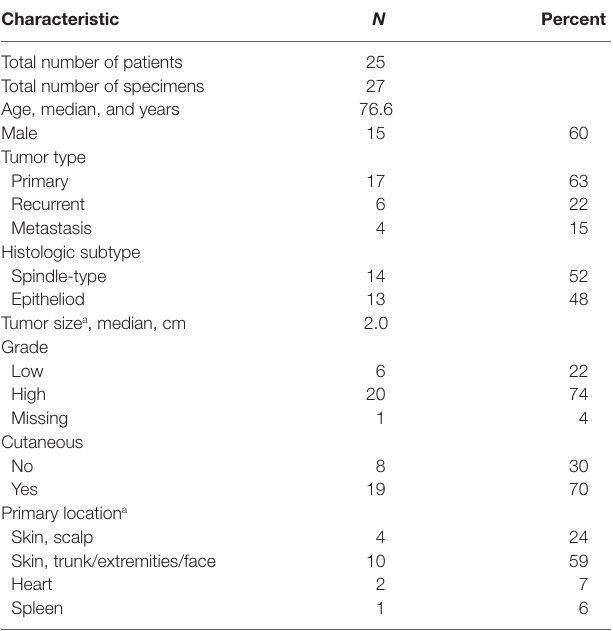
TaBle 1 | Patient characteristics.